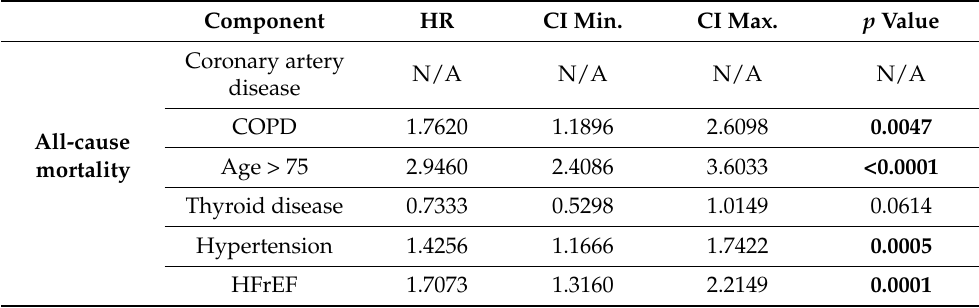
Table 11. Associations of individual C 2 HEST score components with mortality in non-CAD cohort. Component HR CI Min. CI Max. p Value